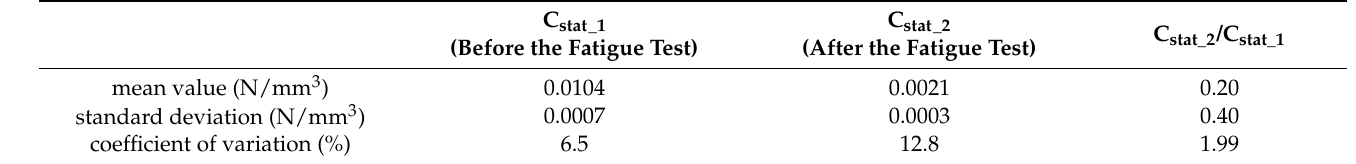
Table 3. Experimental results of the static bedding modulus C stat for Mat A.